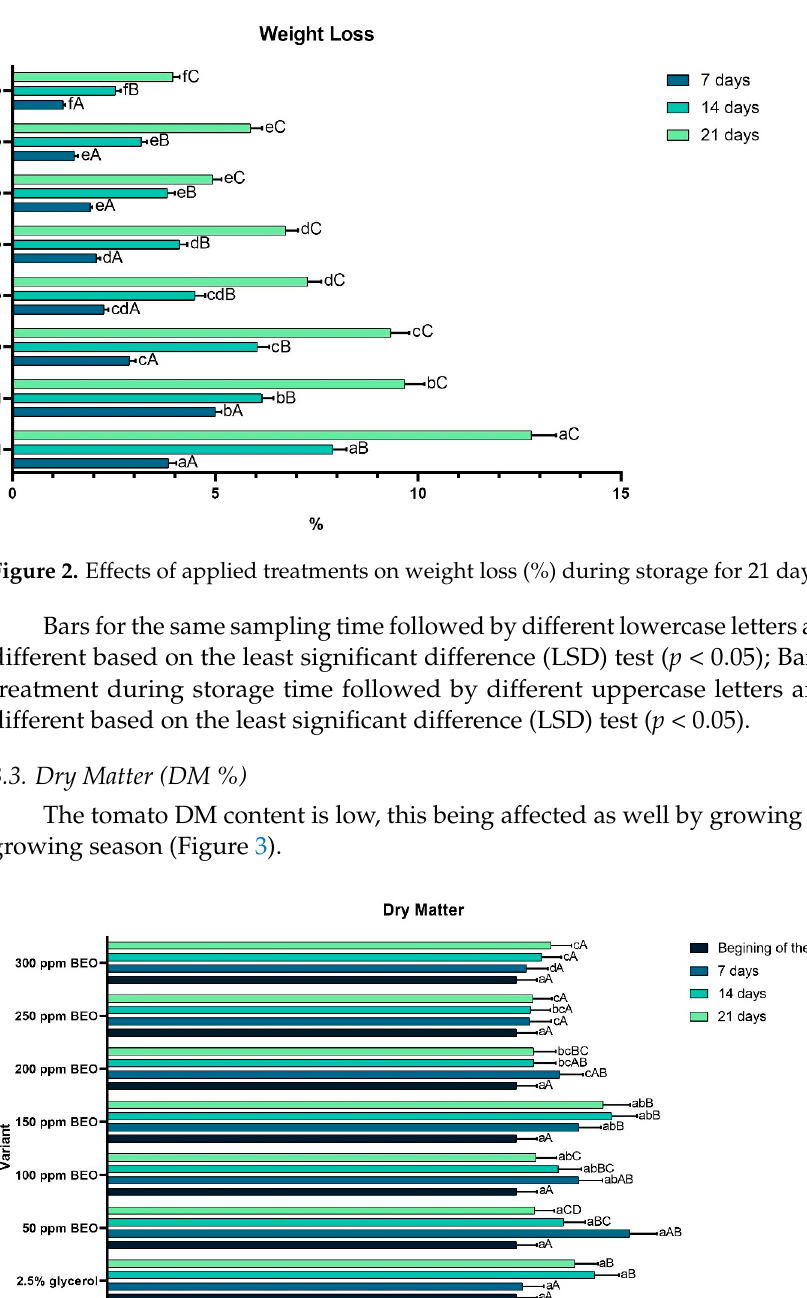
Figure 4. Effects of applied treatments on total soluble solids (%) during storage for 21 days at 8 ± 1 °C. Bars for the same sampling time followed by different lowercase letters are significantly different based on the least significant difference (LSD) test ( p < 0.05). Bars for the same treatment during storage time followed by different uppercase letters are significantly different based on the least significant difference (LSD) test ( p < 0.05).